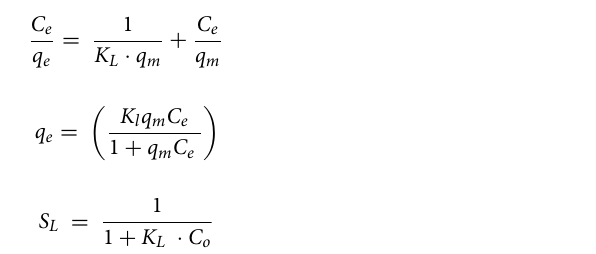
Fit Curve of qt (MF-WTC) Fit Curve of qt (MF-ATC) Fit Curve of qt PA-WTC) Fit Curve of qt (PA-ATC)